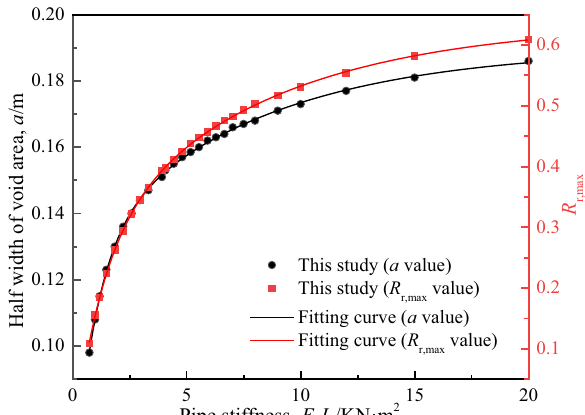
Figure 15. Relative detachment extent between pipeline and soil under different pipeline